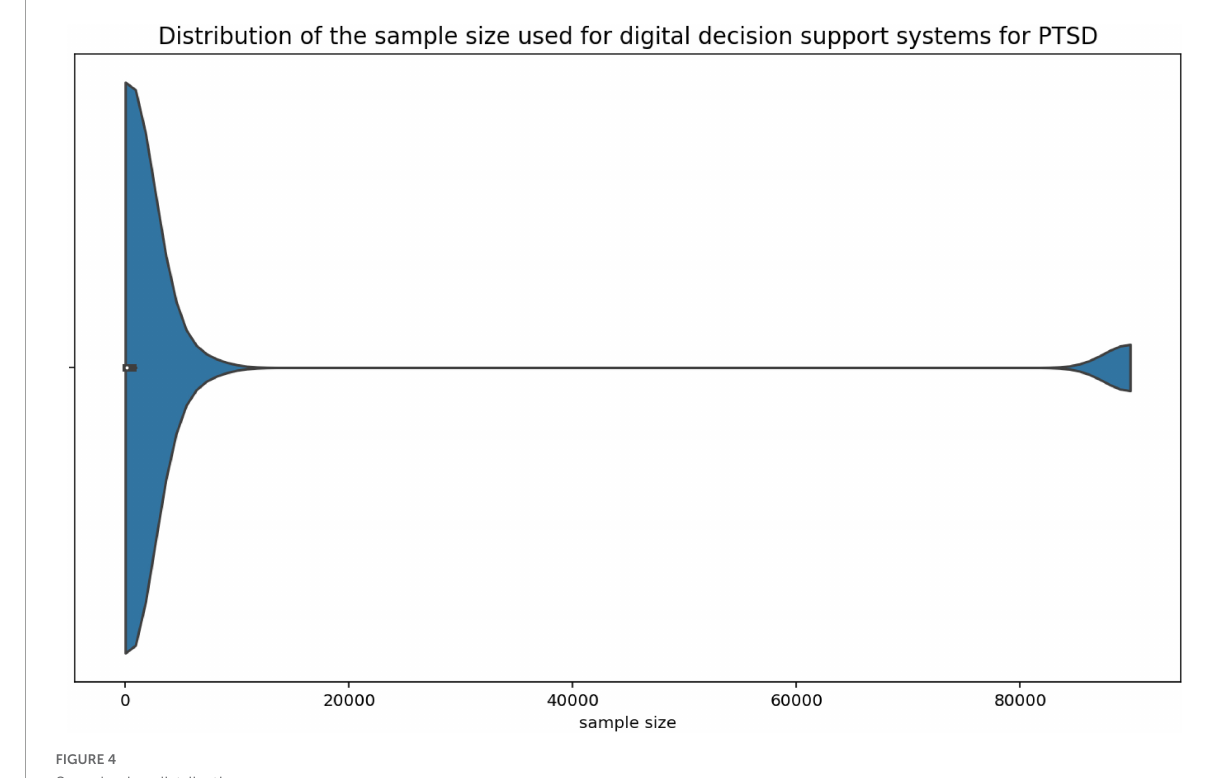
FIGURE4 Sample size